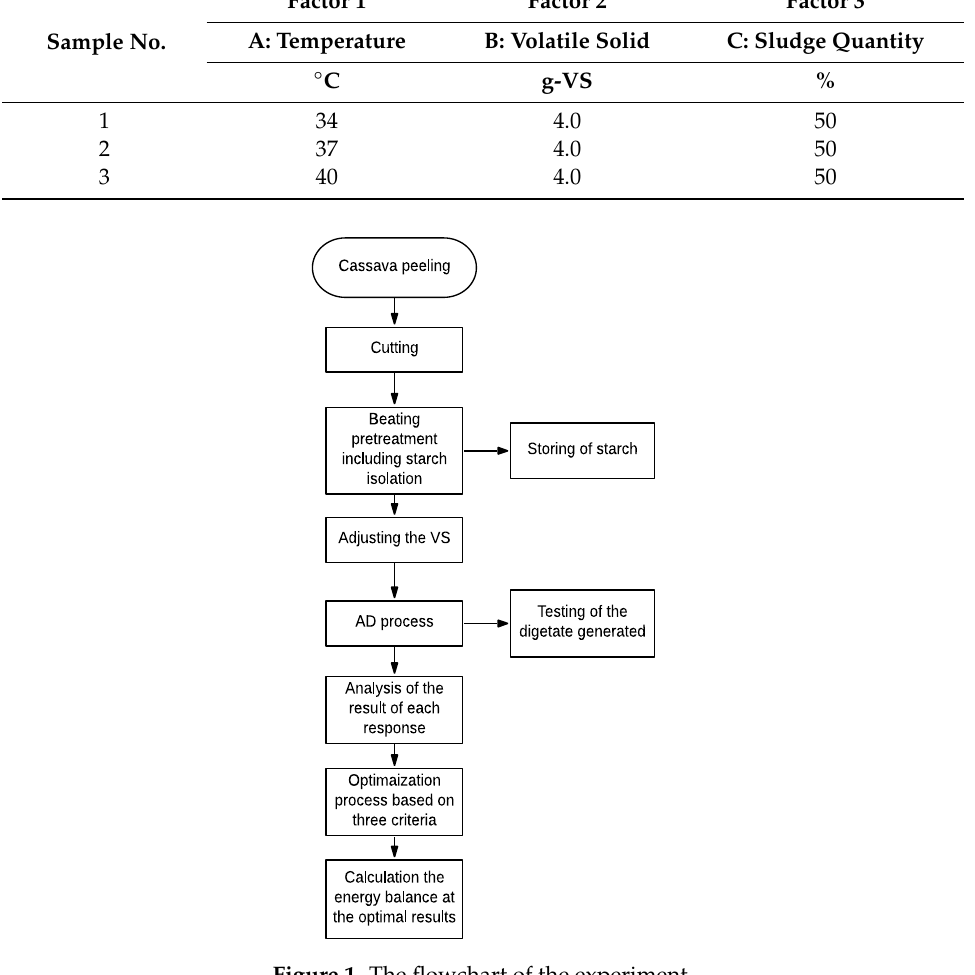
Figure 1. The flowchart of the experiment.